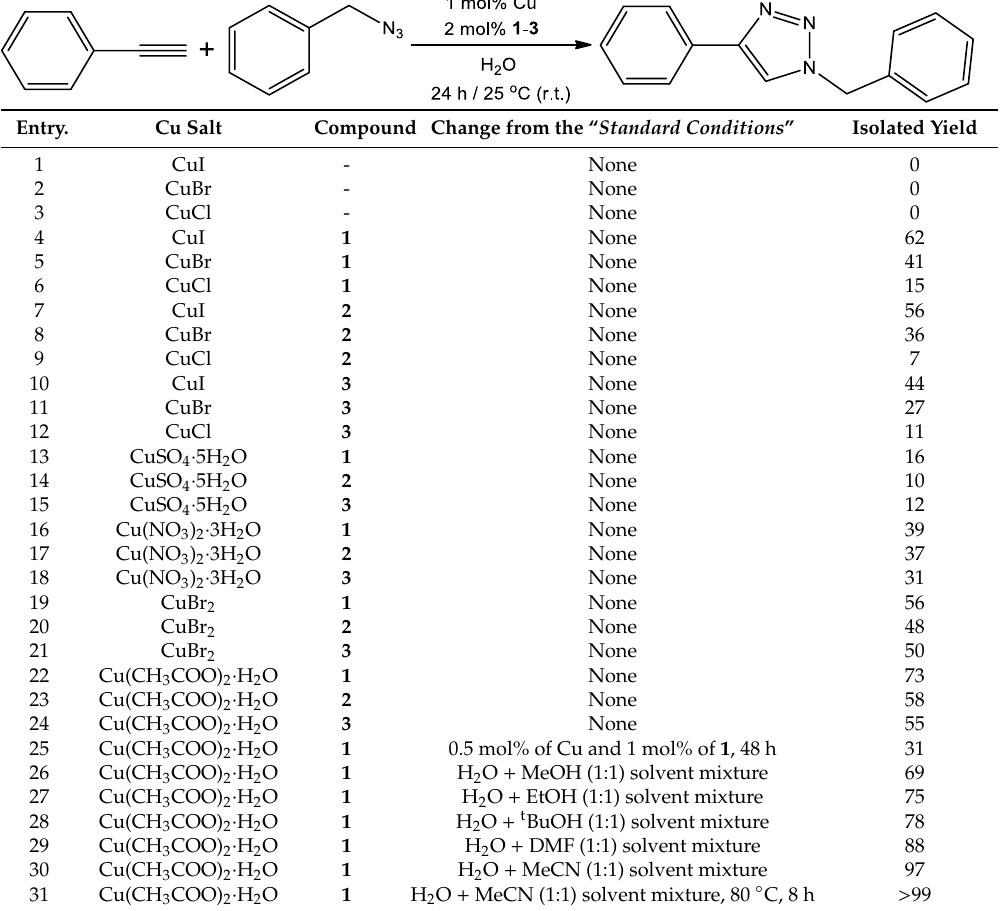
Table 2. Reaction conditions screening for CuAAC a .